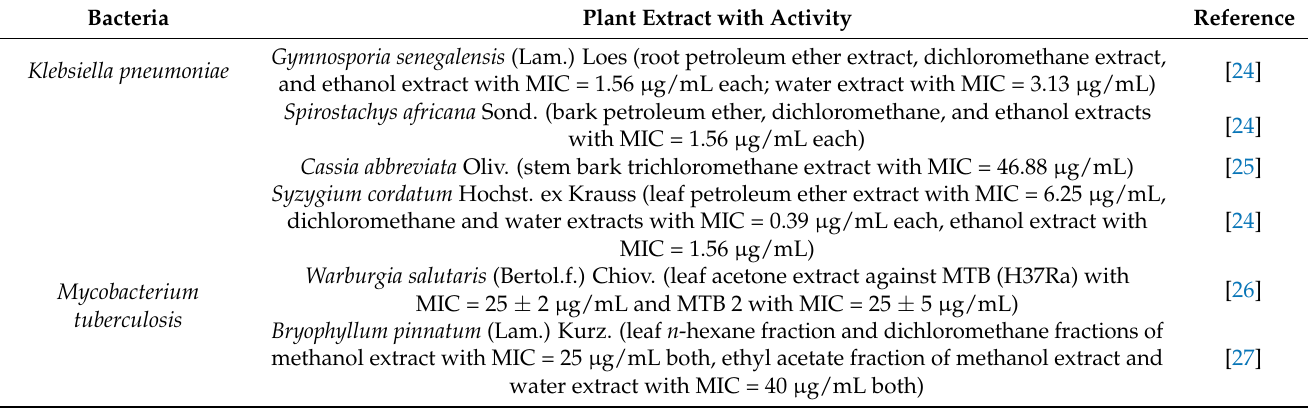
Table 1. Most active plant extracts against bacteria causing respiratory diseases with MIC ≤ 50 µ g/mL (note: only MIC was used for the selection of the plants for Table 1). Bacteria Plant Extract with Activity